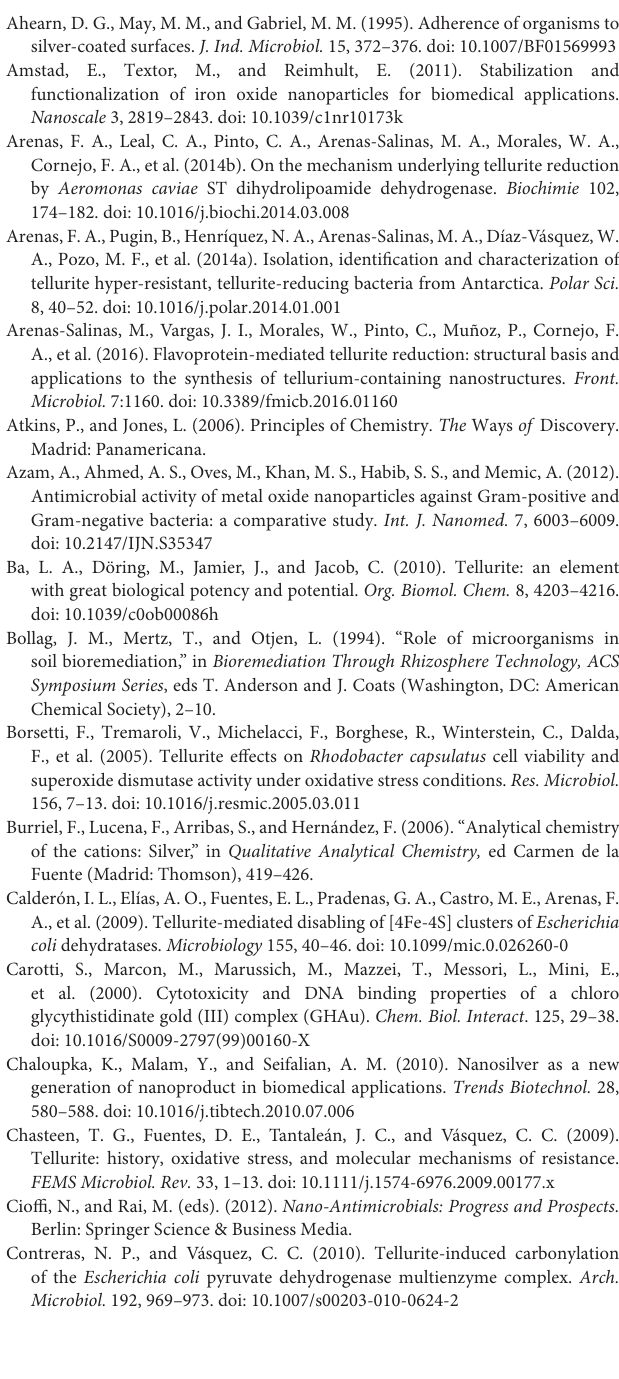
metal(loid)-reductase activity (U/mg protein), showing the dependence on the pH and cofactor. Figure S4 | Growth curves of E. coli and L. monocytogenes exposed to NS. Effect of TeNS synthesized by crude extracts of cells overexpressing the E. cloacae gorA gene in E. coli (A) and L. monocytogenes (B) . Effect of TeNS synthesized using crude extracts of MF09 in E. coli (C) and L. monocytogenes